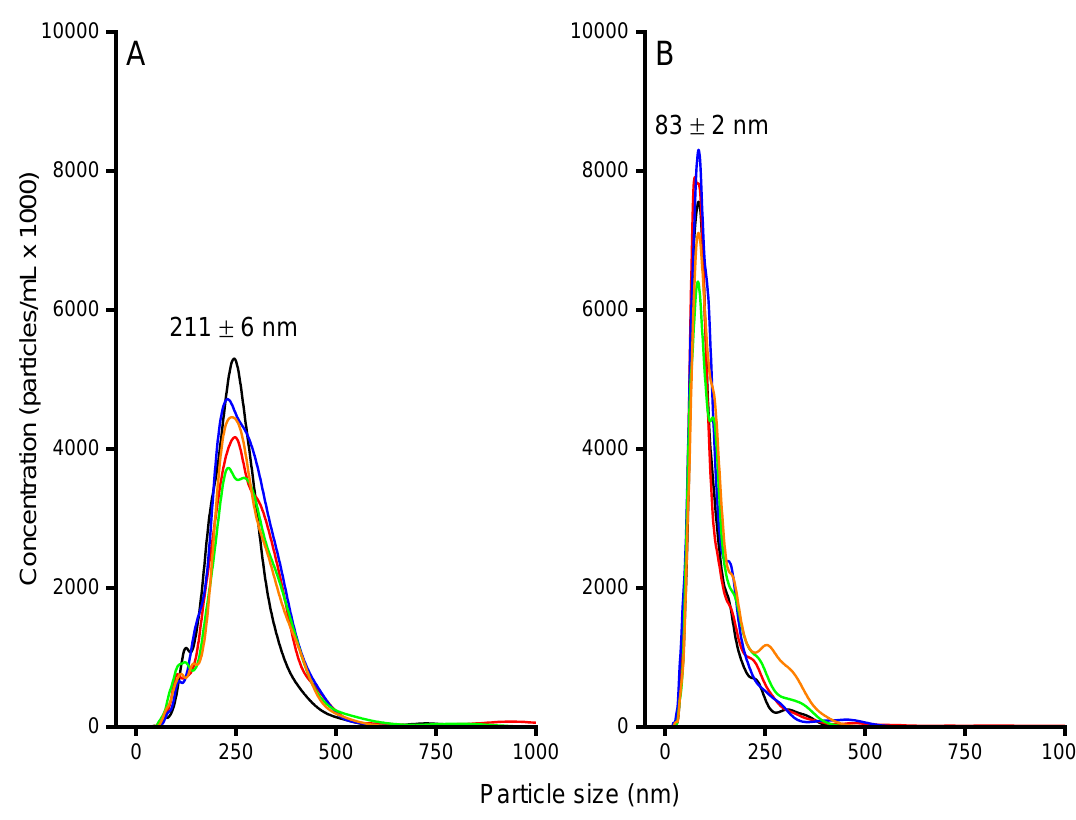
Figure 2. Nanoparticle tracking analysis (NTA) curves for ( A ) Alg/PLL and ( B ) Alg/NITEGE nanoparticles. The particles were prepared according to the standard procedure before the dispersions were diluted by 1:10. Depicted are five different measurements to show the reproducibility.